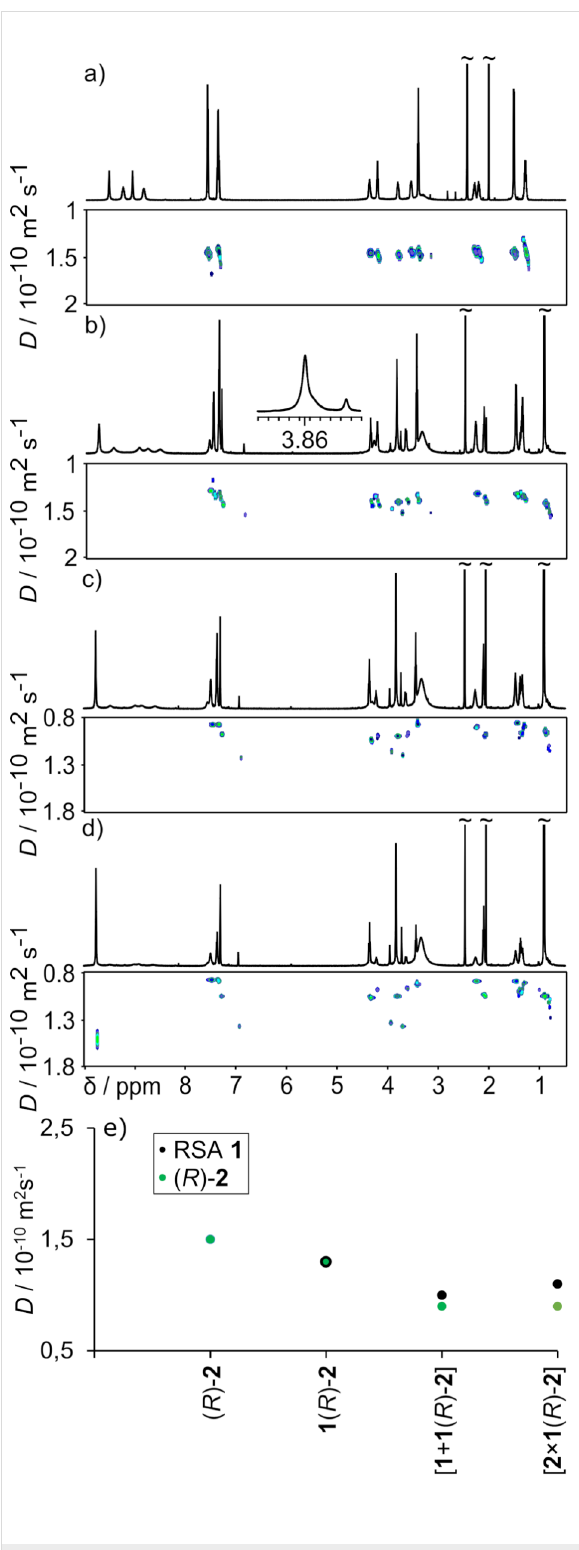
Figure 7: 1 H NMR and DOSY spectra of ( R )- 2 (a); [ 1 ( R )- 2 ] (b) (inset show the shape signals f, DMSO- d 6 , 298K, 600 MHz); [ 1 + 1 ( R )- 2 ] (c); [2 × 1 + 1 ( R )- 2 ] (d); Cumulative plot of diffusion coefficients (e) (DMSO- d 6 , 298 K, 600